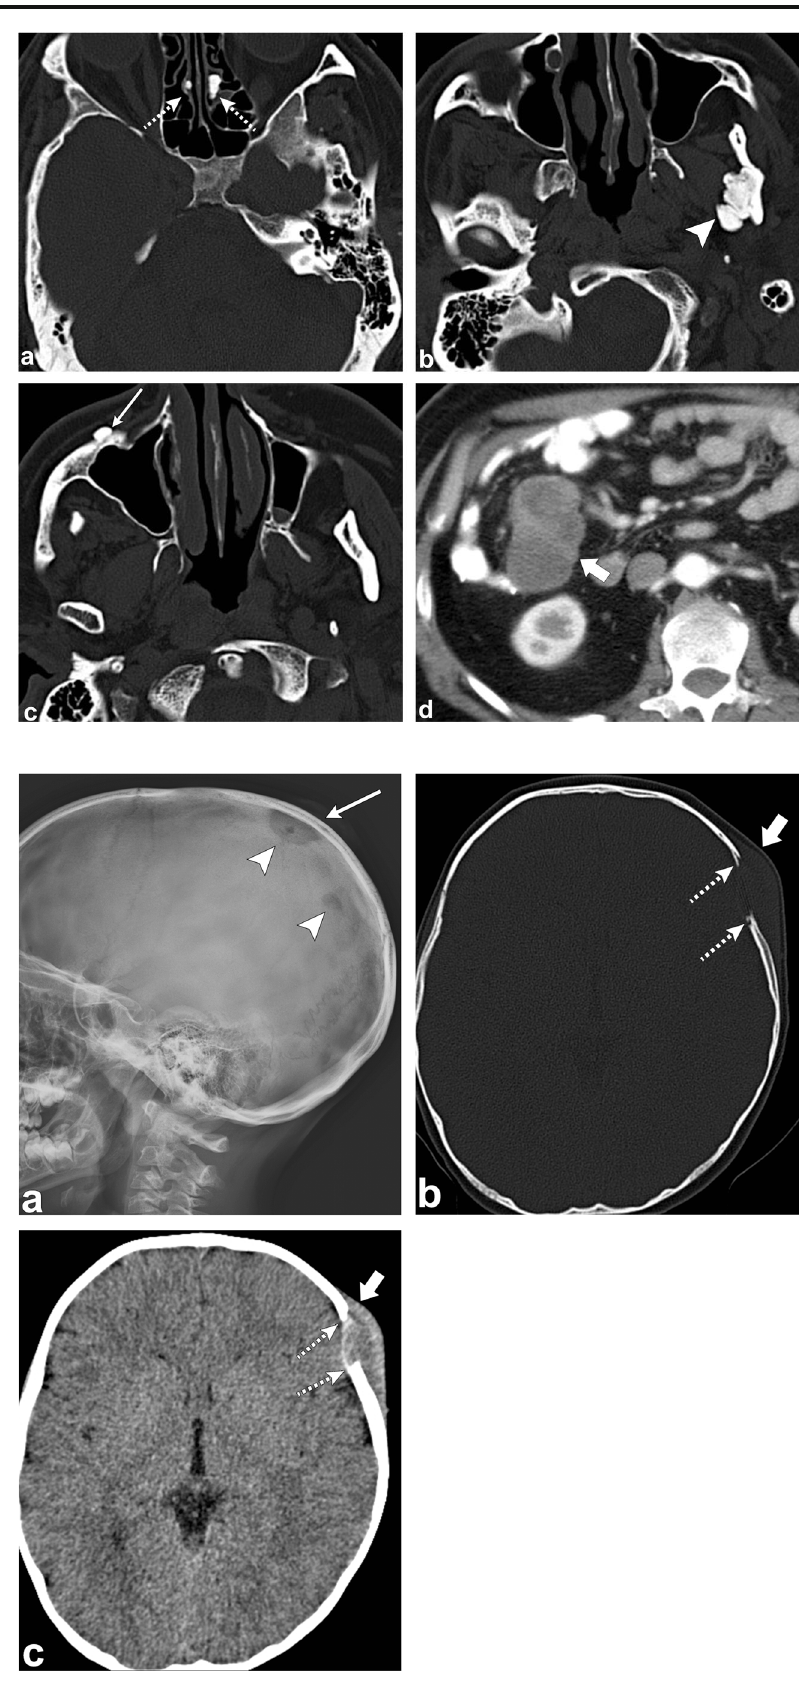
Fig. 4 Gardner Syndrome (multiple osteomas). Axial head CT images ( a – c ) show multiple osteomas in the ethmoid air cells ( dashed arrows ), left ramus of the mandible ( arrowhead ) and right anterior wall of the maxillary sinus ( thin arrow ). This patient was also found to have a mesenteric desmoid tumour ( thick arrow , d